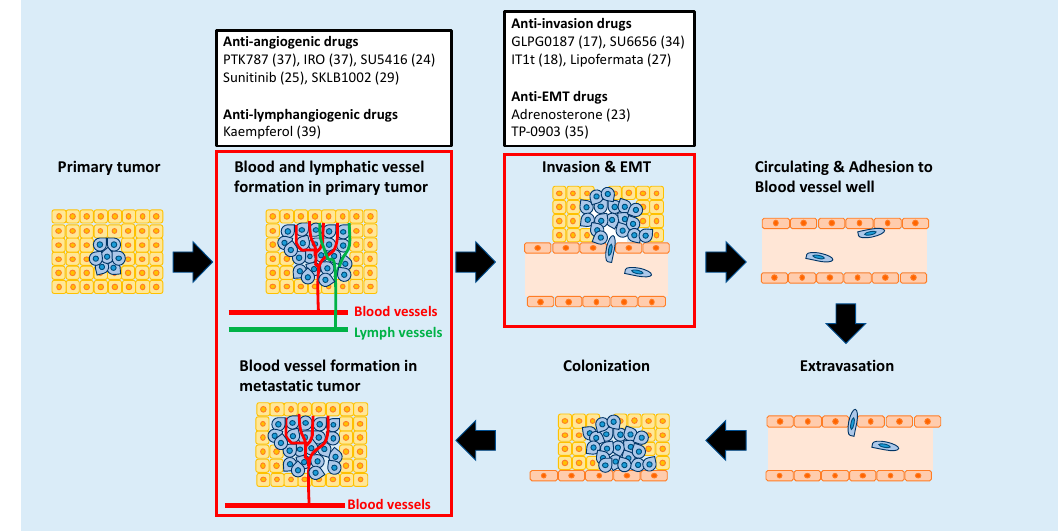
Figure 1. Anti-metastatic drugs identified through zebrafish-based screening that target different stages of metastasis. The numbers in parentheses indicate reference.